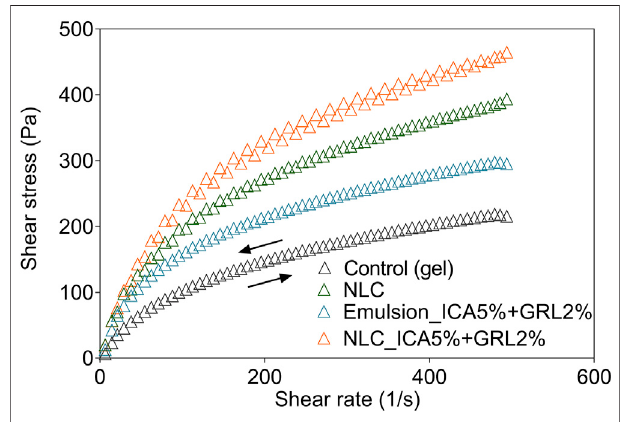
FIGURE3 | Rheograms ofshear stress variation according to shear rate for the control HPMC hydrogel, the NLCs formulation without active ingredients, the emulsion with 2% geraniol (GRL) and 5% icaridin, and the NLCs formulation with 2% geraniol and 5% icaridin.